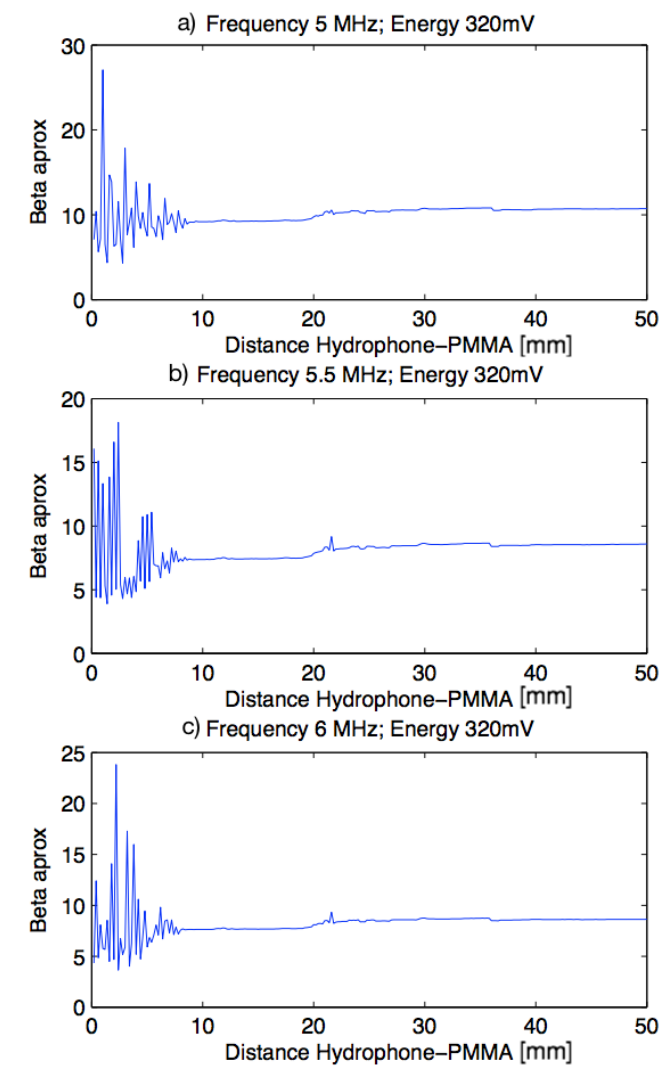
Figure 9. Plots beta versus distance specimen-hydrophone. ( a ) Frequency of 5 MHz and Energy of 320 mV; ( b ) Frequency of 5.5 MHz and Energy of 320 mV; ( c ) Frequency of 6 MHz and Energy of 320